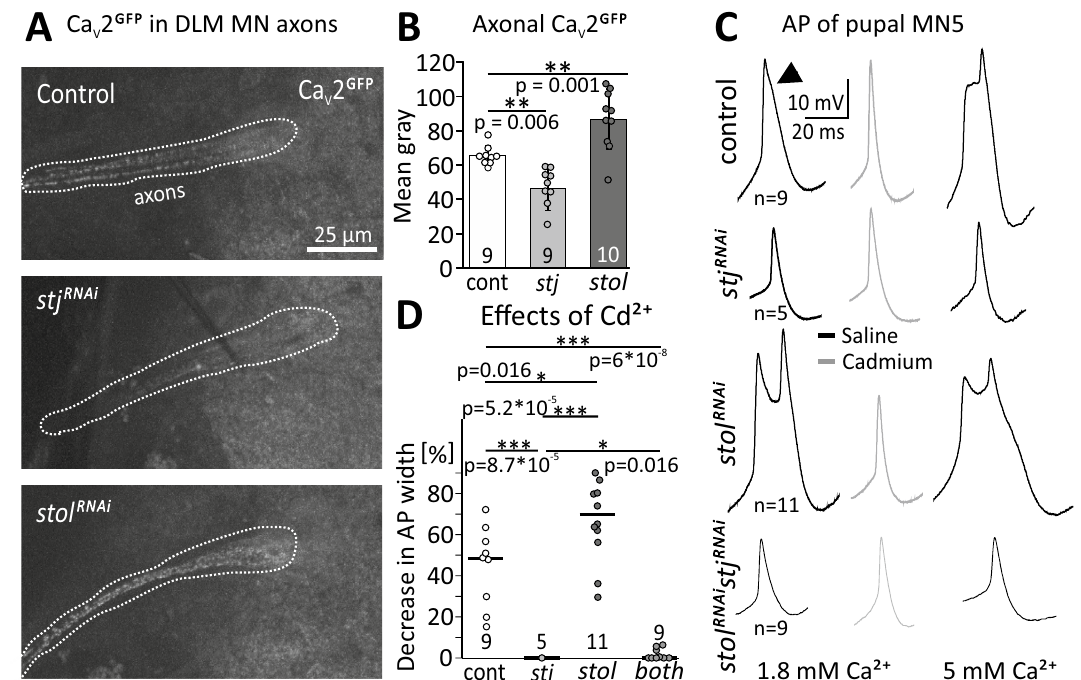
Figure 3. stj RNAi and stol RNAi have different effects on axonal Ca v 2 channel abundance and AP shape. (A–C) Projection views (10 optical sections) of DLM MN axons with endogenously tagged Ca v 2 GFP channels, with reported normal function 53 . ( A ) As compared to control (top panel) stj RNAi (middle panel) decreases Ca v 2 GFP label in DLM MN axons (encircled by dotted white line), whereas stol RNAi (bottom panel) increases labeling intensity. ( B ) Quantification of mean gray of Ca v 2 GFP puncta in confocal sections reveals a ~ 20% significant decrease in stj RNAi (light gray bar, ** p = 0.006, n = 9) but a ~ 20% significant increase in stol RNAi (dark gray bar, ** p = 0.001, n = 10) as compared to control (white bar, N = 9). Error bars represent SD; statistics, one-way ANOVA, LSD post-hoc test. ( C ) Pupal MN5 action potentials (APs) were recorded in 1.8 (left) and 5 mM Ca 2+ saline (right) and elicited by somatic square pulse current injection. APs showed a Ca 2+ shoulder ( C , top, left trace, see arrow) that was abolished by the VGCC blocker Cd 2+ (500 µM; C , top, gray trace) and broadened in high Ca 2+ (C , top, right trace). APs were smaller and narrower in stj RNAi ( C , second row, left trace) as compared to control ( C , top, left trace) and were neither narrowed by Cd 2+ ( C, second row, gray trace) nor broadened in 5 mM Ca 2+ ( C , second row, right trace). stol RNAi often caused a double peak ( C , third row, left trace) and APs were broadened in high Ca 2+ ( C , third row, right trace), but abolished in Cd 2+ ( C , third row, gray trace). stj RNAi stol RNAi resulted in APs that were as small as with stj RNAi but slightly broader, both in 1.8 ( C , bottom, left trace) and in 5 mM Ca 2+ (right trace). Cd 2+ caused a small narrowing effect ( C , bottom, gray trace). (D) Cadmium reduced AP half width significantly more in control (* p = 0.012) than in stj RNAi ( ***p < 0.001) but significantly less than with stol RNAi ( *p = 0.016). In stj RNAi stol RNAi the Cd 2+ effect was small, but significantly larger as compared to stj RNAi (* p = 0.016). Diagrams show single data points and medians (Kruskal–Wallis ANOVA, Dunn’s post-hoc